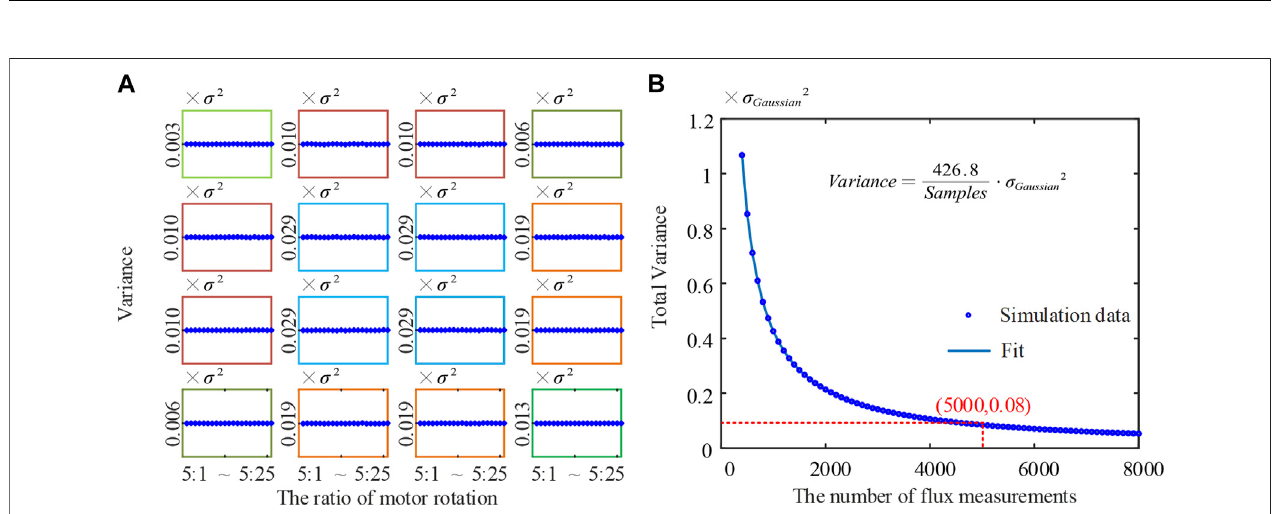
FIGURE 8 | Theoretical analysis for Gaussian noise (A) estimation variances of Mueller matrix elements when the ratio of motors ’ rotation speed is 5 ω : N ω and (B) total estimation variances dependency on the number of sampling points.